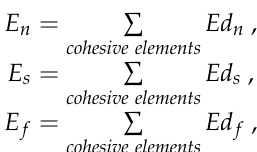
Table 1. The size distribution of aggregates in experiment [46].